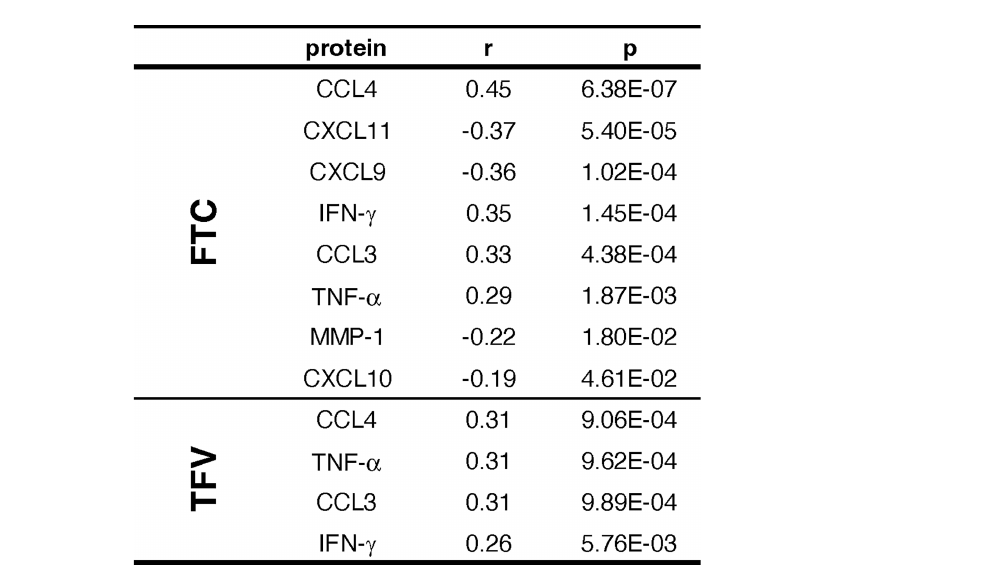
FIGURE 7 Correlation between drug levels and proteins signi fi cantly modulated by